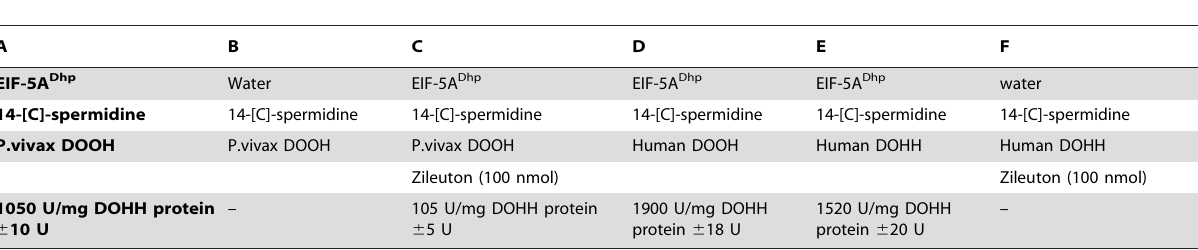
Table 1. Determination of DOHH activity from P. vivax and human.